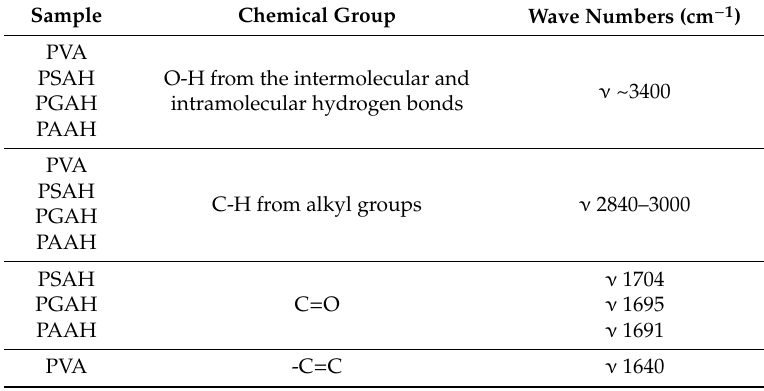
Figure 3. FT-IR spectra of PSAH, PGAH, and PAAH. Table 2. Vibration modes and band frequencies in polyvinyl alcohol (PVA) and PVA crosslinked with SA, GA, and AA.